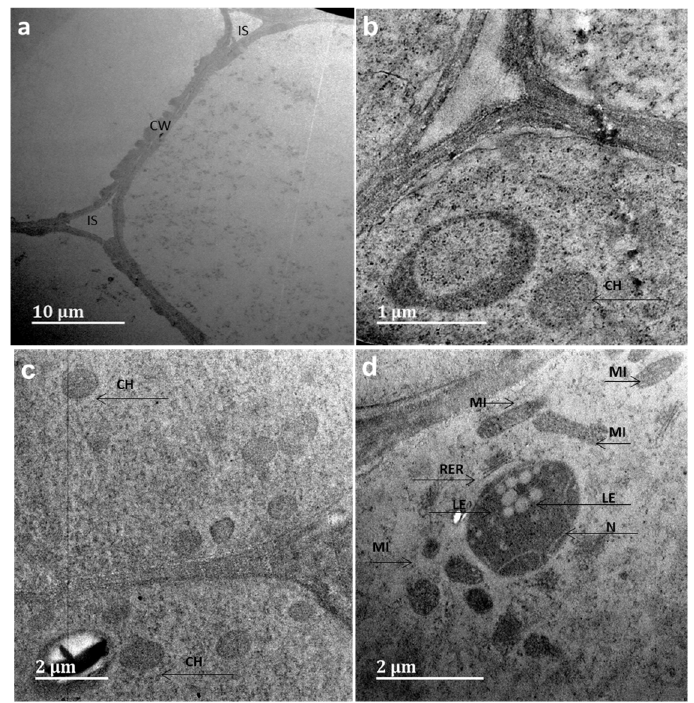
Figure 8. TEM of the ultrastructure of meristematic cells of the control ( a , b ) and Ag@Se ( c , d ) treated Allium cepa root. S = intracellular space, CW = cell wall, CH= chloroplast, MI= mitochondria, N = nucleus, RER = rough endoplasmic reticulum, LE = lesions.